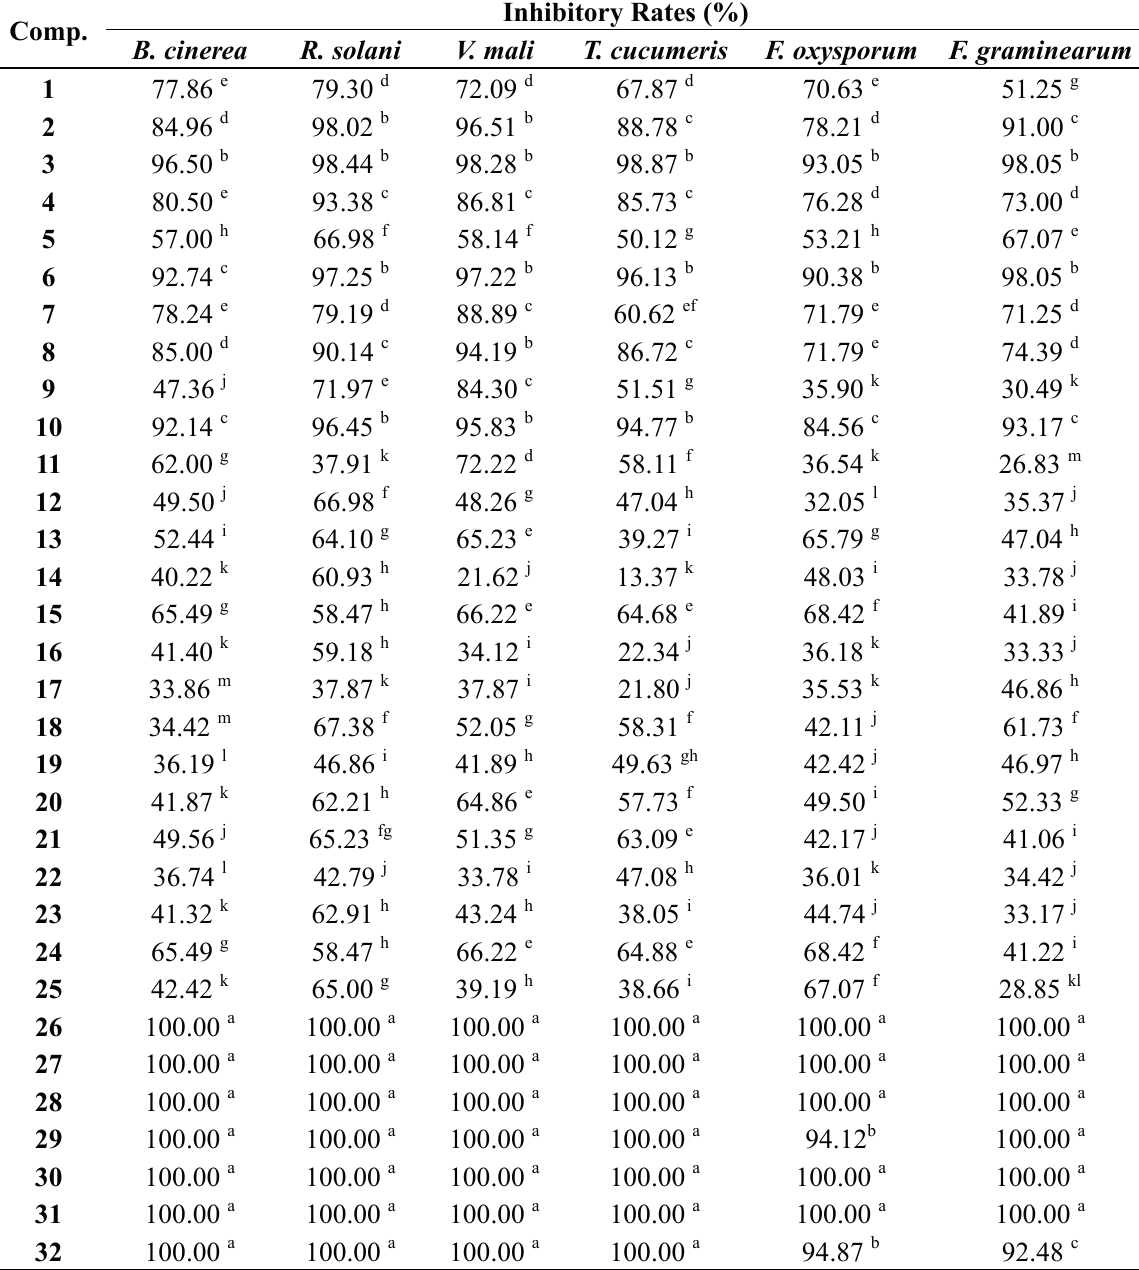
Table 1. Fungicidal activities of compounds 1 – 32 at a concentration of 100 mg/L.